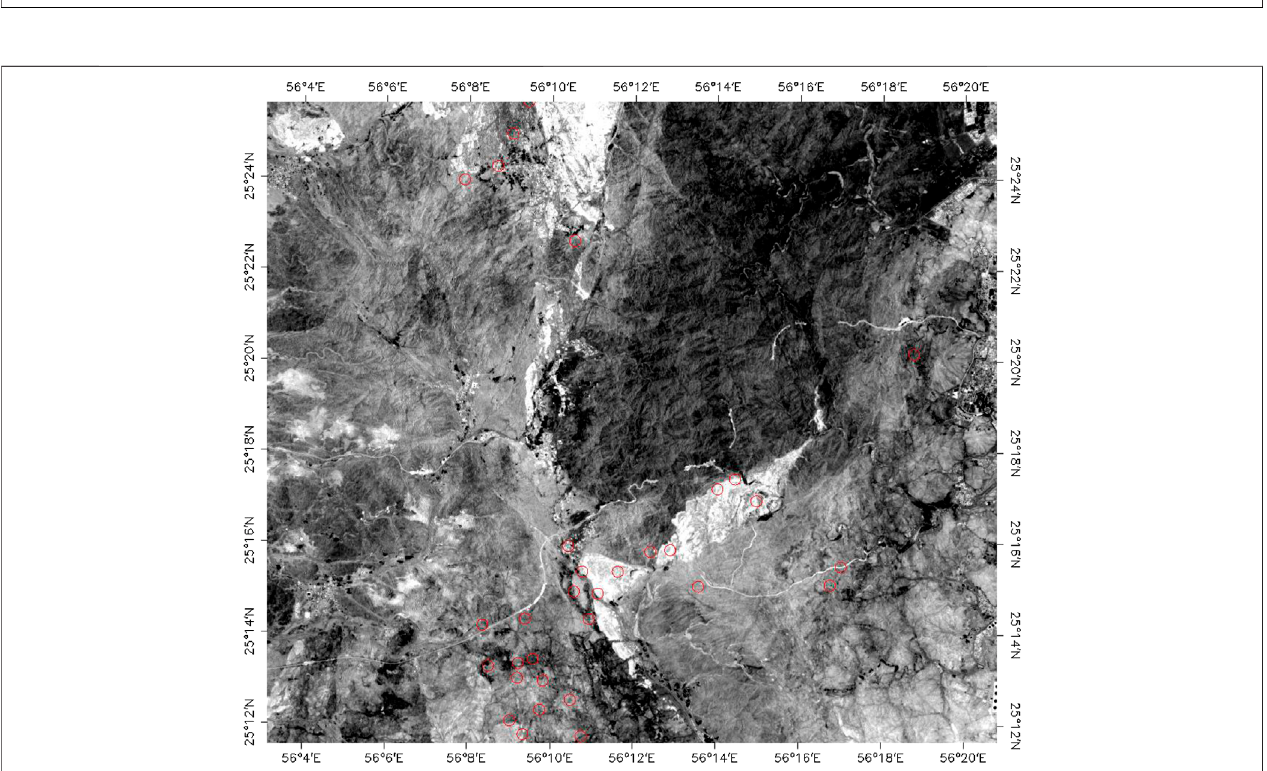
FIGURE 16 | Ratio image of band 7/6 of the study area. The metamorphic sole is displayed in white pixels. The locations of copper is shown in red circles.